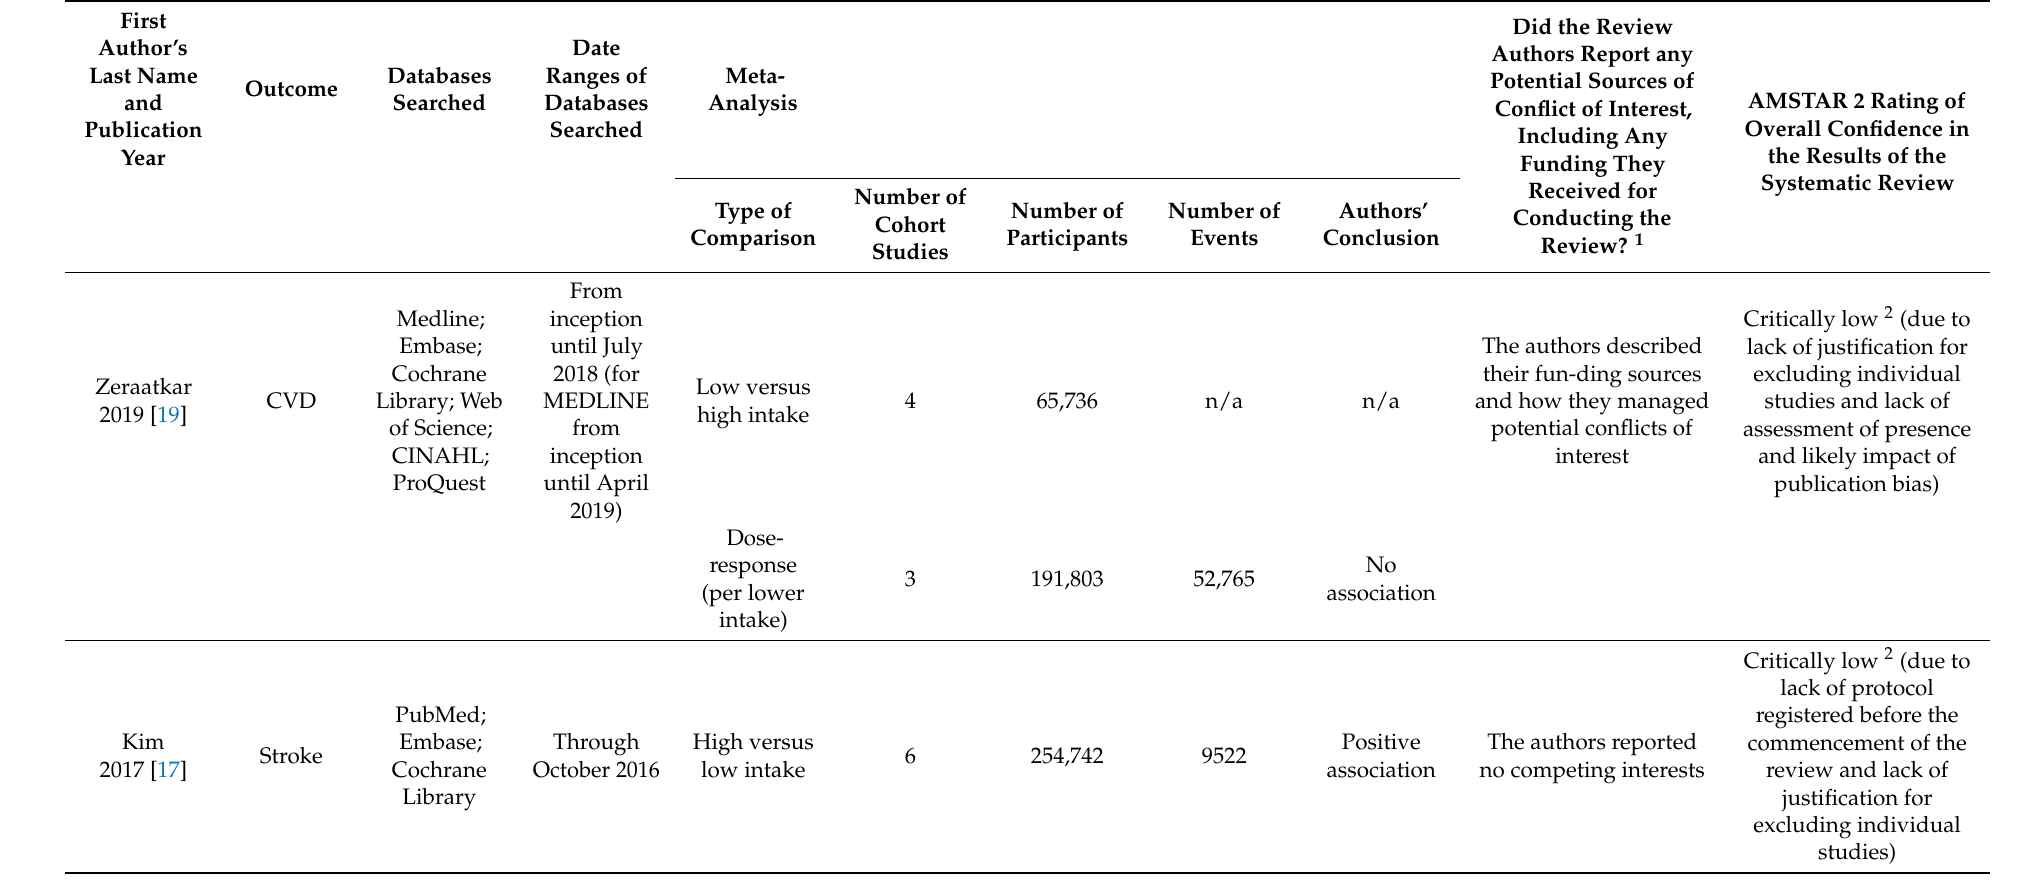
Table 1. Descriptive characteristics of systematic reviews on associations between unprocessed red meat and CVD and